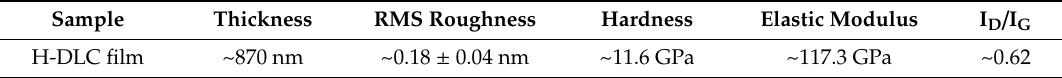
Figure 1. ( a ) Indentation force-depth curve of H-DLC film with maximum depth of 80 nm. ( b ) Raman spectrum of pristine H-DLC film. Two peaks involving D peak at ~1335 cm − 1 and G peak at ~1540 cm − 1 were deduced. Table 1. Intrinsic properties of H-DLC film.